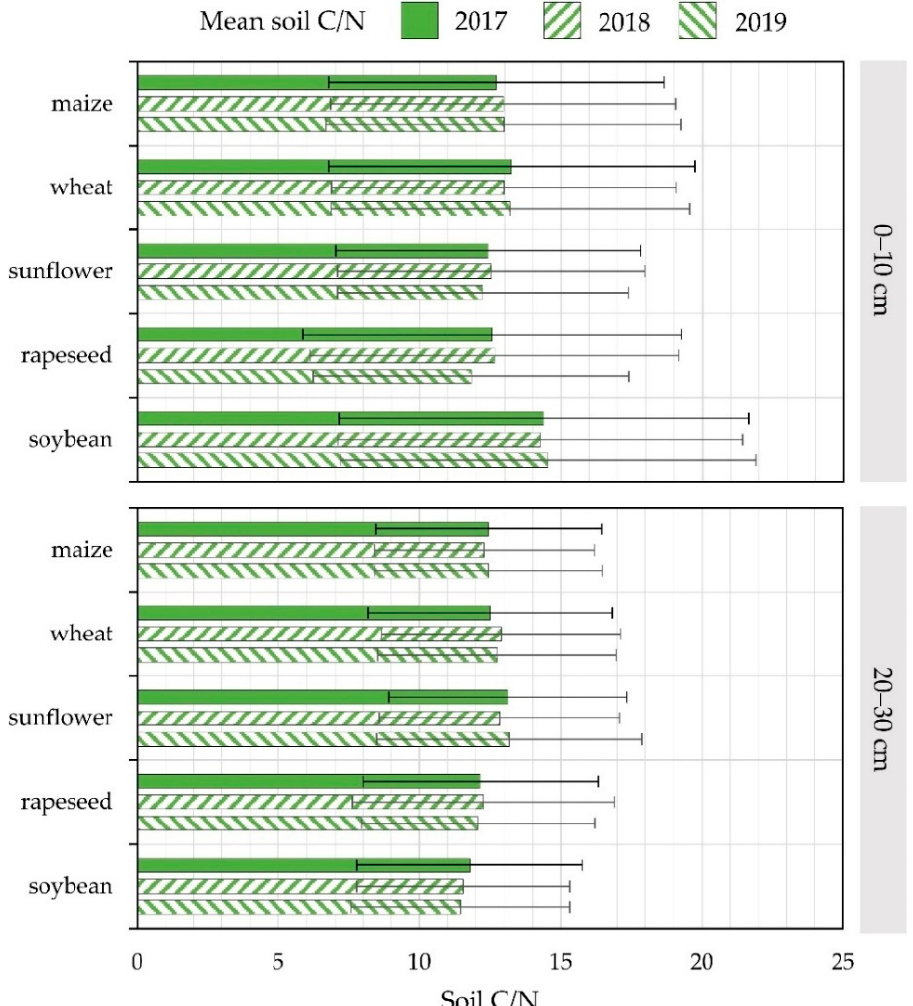
Figure 8. Mean and standard deviation values of soil C/N for five major crops for 2017 and projected values for 2018 and 2019.